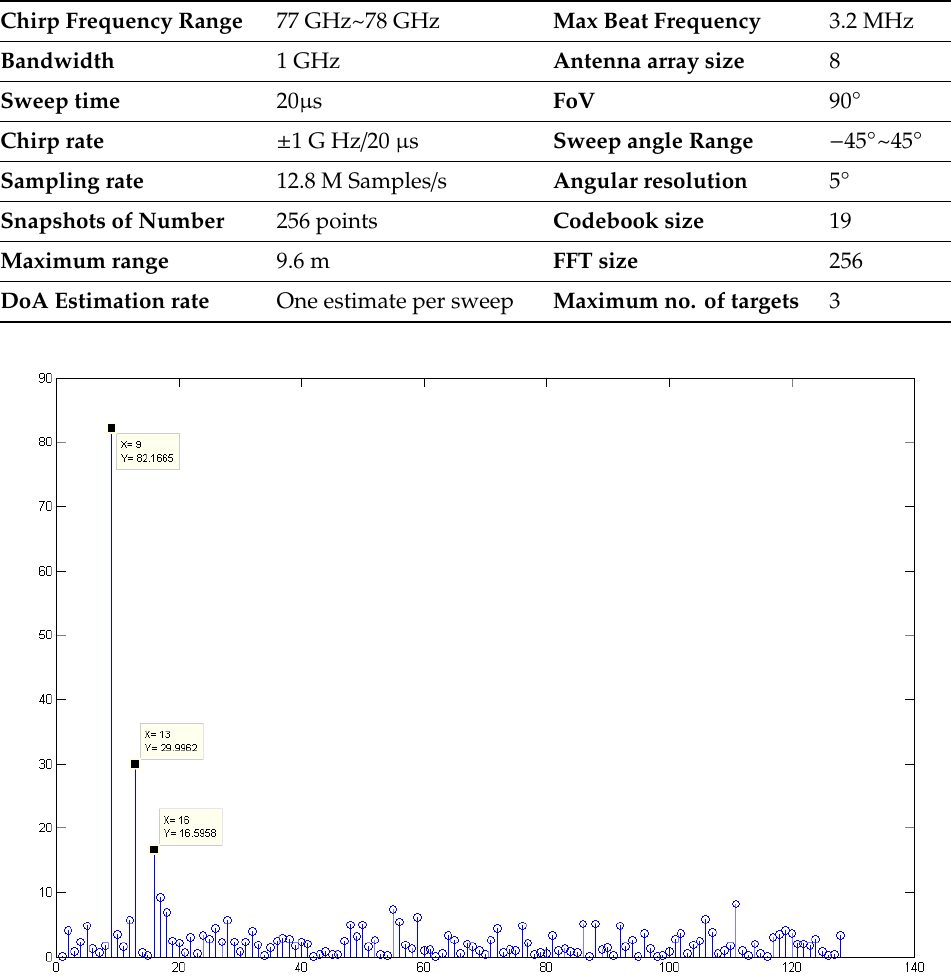
Figure 9. FFT spectrum of Frequency Modulated Continuous Waveform (FMCW) radar signal from a single antenna.